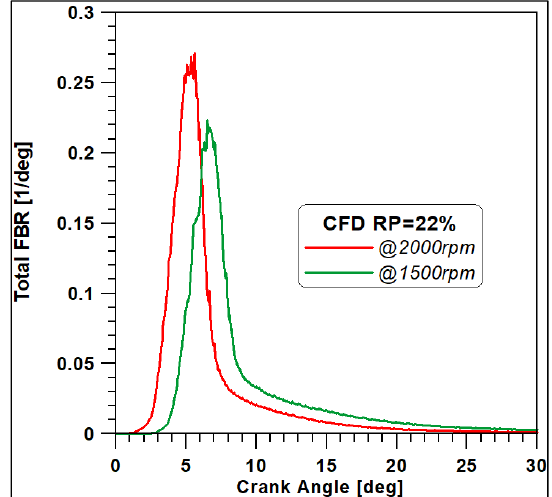
Figure 11. Total fuel burning rate for the two cases.